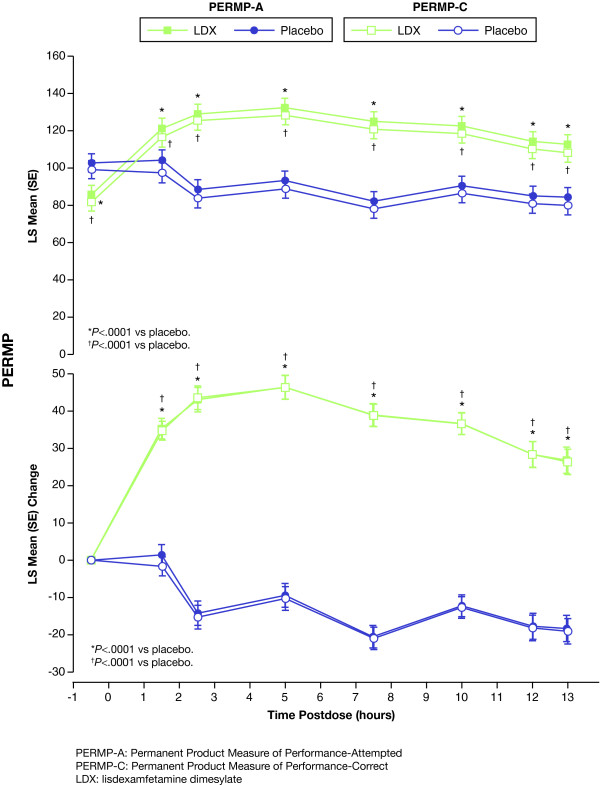
Time course of PERMP-A (closed symbols) and PERMP-C (open symbols) assessment over the laboratory school day. LS mean (SE) actual scores (top) and change from predose (bottom) for LDX (squares) and placebo (circles) at predose (-0.5 h) and at 1.5, 2.5, 5, 7.5, 10, 12, and 13 h postdose. Scores were compared using a linear mixed model with sequence, period, and treatment as fixed effects and subject within sequence as a random effect. Higher scores denote improvement. *Denotes P < .0001 LDX compared with placebo for PERMP-A. †Denotes P < .0001 LDX compared with placebo for PERMP-C.